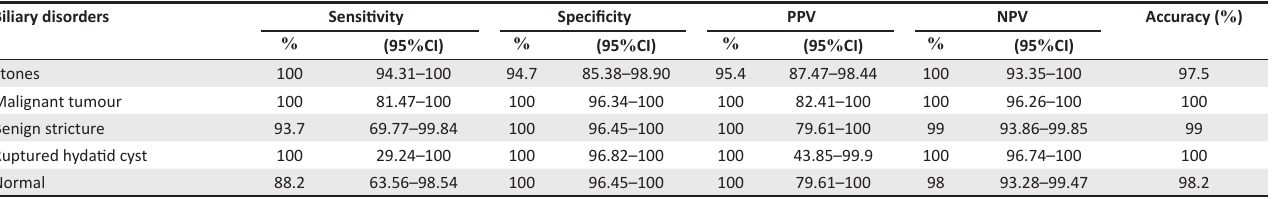
TABLE 3: The statistical results of magnetic resonance cholangiopancreatography findings according to endoscopic retrograde cholangiopancreatography results as the gold standard. Biliary disorders